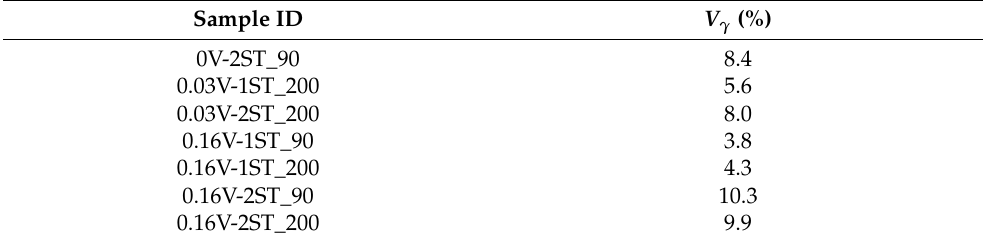
Table 3. Measured volume fractions of RA of the experimental steels after Q&P treatment.